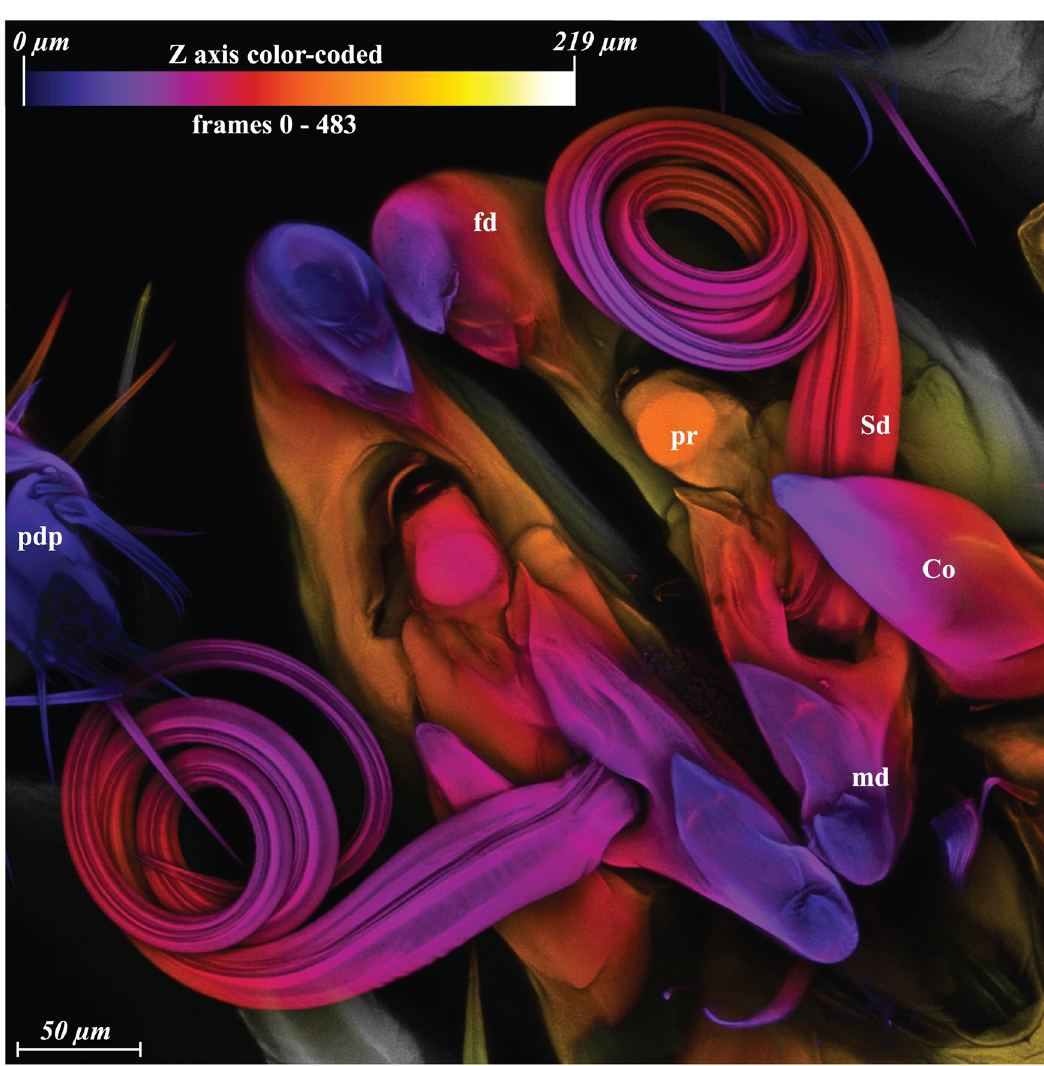
Fig 1. Megalolaelaps colossus male, maximum intensity projection (MIP) of CLSM image of the spermatodactyl with color coded z axis. Co, corniculi; fd, fixed digit; md, movable digit; pdp, pedipalp; pr, putative reservoir; Sd,